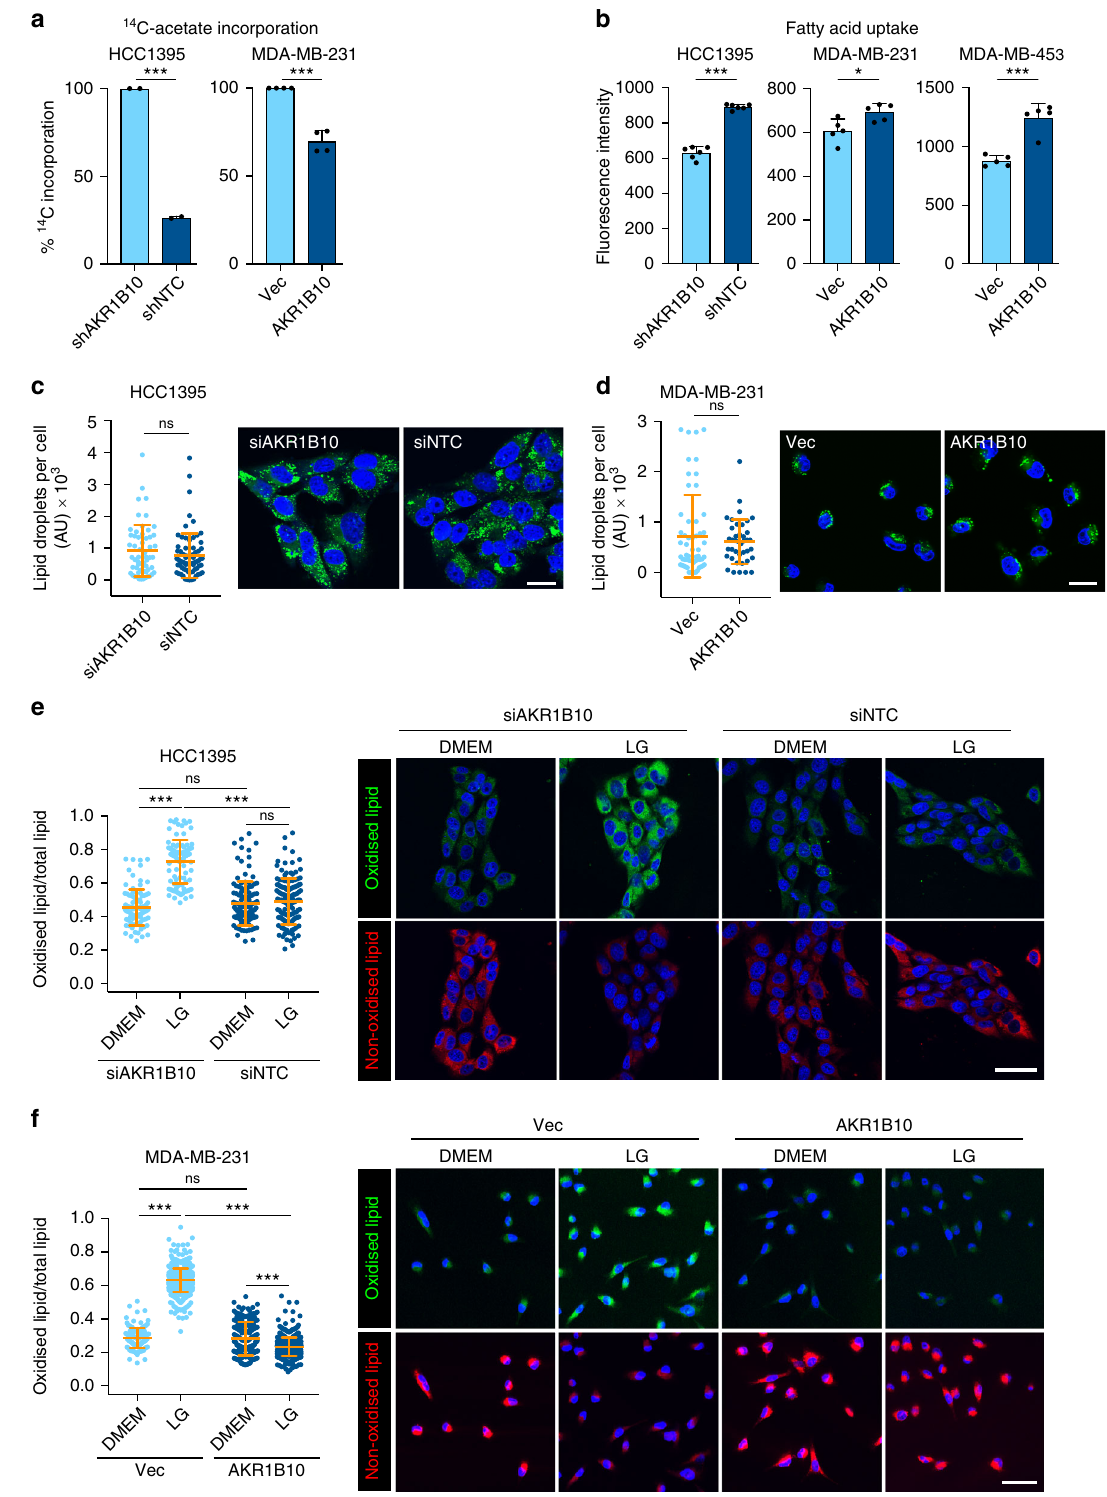
Fig. 5 AKR1B10 limits lipid peroxidation. a 14 C-acetate incorporated into lipids. Data from three independent experiments relative to AKR1B10 Low cells. b Fatty acid uptake. n = 5 ± SD. c HCC1395 and d MDA-MB-231 cells labelled with BODIPY 493/503. Data shows lipid droplet content per cell analysed in 3 – 5 fi elds of view ± SD. Scale bar, 25 μ m. e HCC1395 and f MDA-MB-231 cells cultured in DMEM or LG DMEM and stained with BODIPY 581/591 C11. Quanti fi cation of oxidised (green) BODIPY probe as a ratio of total probe (green plus red) per cell in 4 – 5 fi elds of view per sample ± SD. Representative images; scale bar, 50 μ m. ns, not signi fi cant; * P < 0.05; *** P < 0.001, unpaired t -test ( a – d ). ns, not signi fi cant; *** P < 0.001, two-way ANOVA